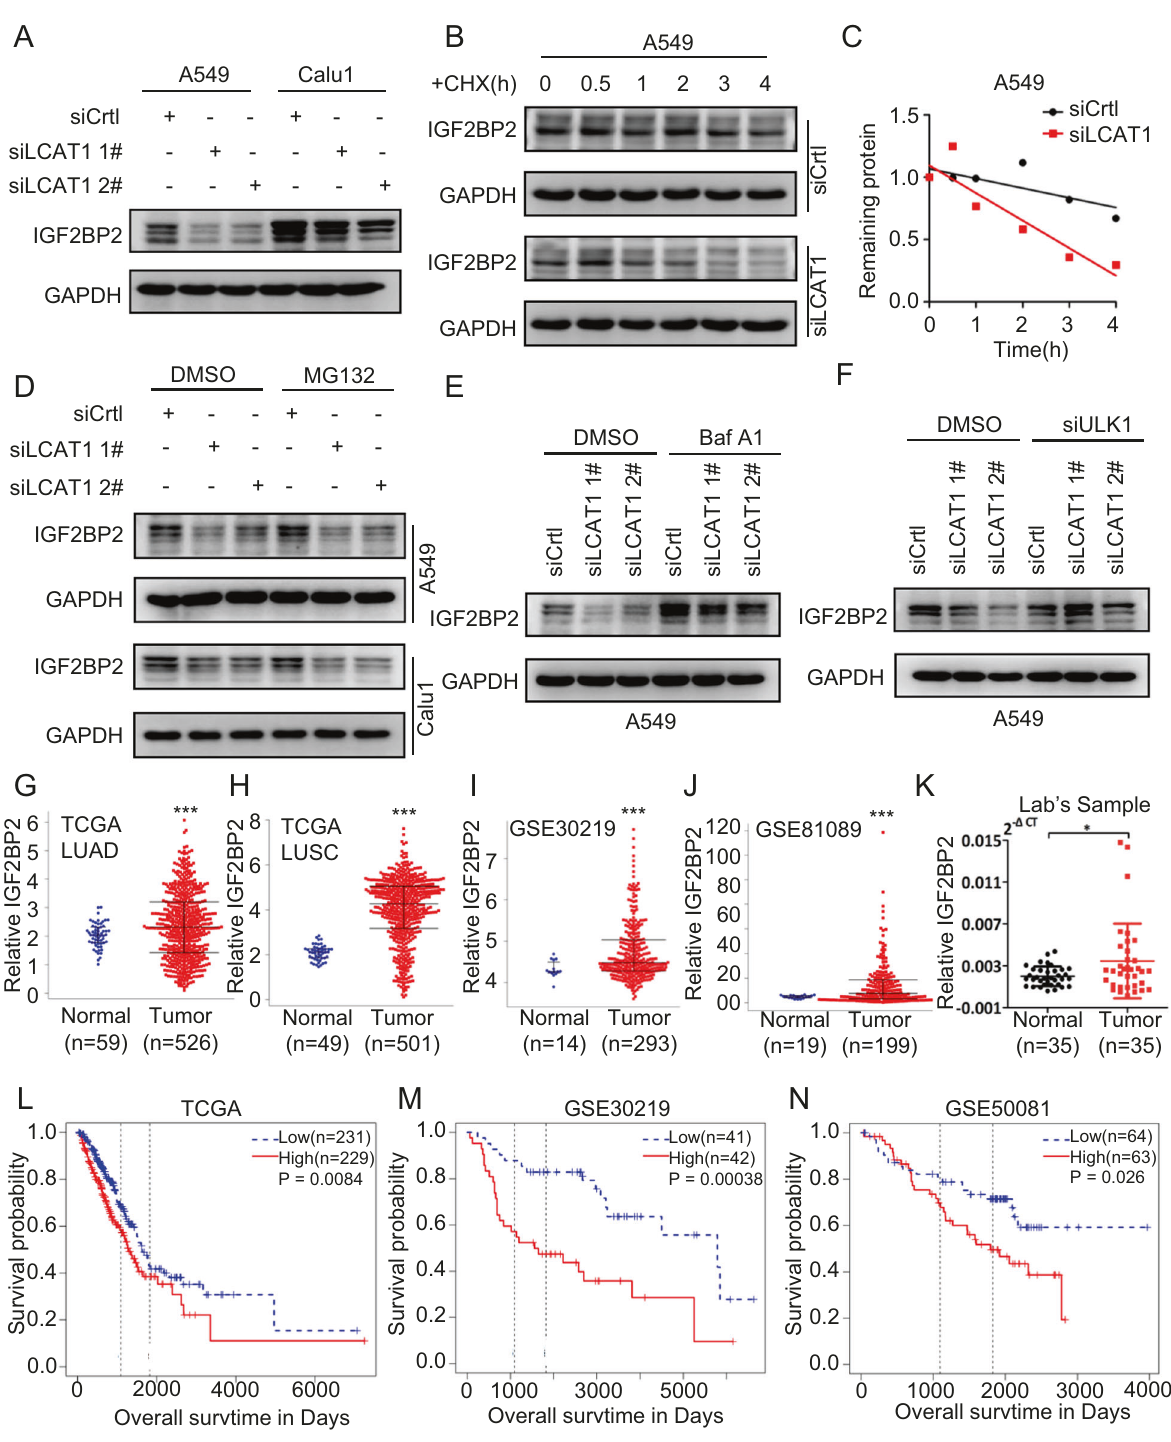
Fig. 2 LCAT1 regulates IGF2BP2 protein stability, and IGF2BP2 is upregulated and associated with poor survival in lung cancer patients. A Western blot was used to detect the IGF2BP2 protein level in LCAT1 knockdown and control cells. B , C Stability of IGF2BP2 protein in LCAT1 knockdown and control cells, with or without CHX treatment. D IGF2BP2 protein levels in LCAT1 knockdown and control cells, with or without treatment of the protease inhibitor MG-132. E IGF2BP2 protein levels in LCAT1 knockdown and control cells treated with different concentrations of the autophagy inhibitor Ba fi lomycin A1. F IGF2BP2 protein levels in ULK1 knockdown and control cells. G – J The relative expression level of IGF2BP2 in TCGA-LUAD, TCGA-LUSC, GSE30219, and GSE81089, respectively. K qPCR was performed to detect IGF2BP2 expression in 35 fresh lung tumor tissues and matched adjacent non-tumor tissues. L – N Kaplan – Meier curves of overall survival of lung cancer patients based on IGF2BP2 mRNA expression. Data were presented as mean ± SD. * P < 0.05; ** P < 0.01; *** P <